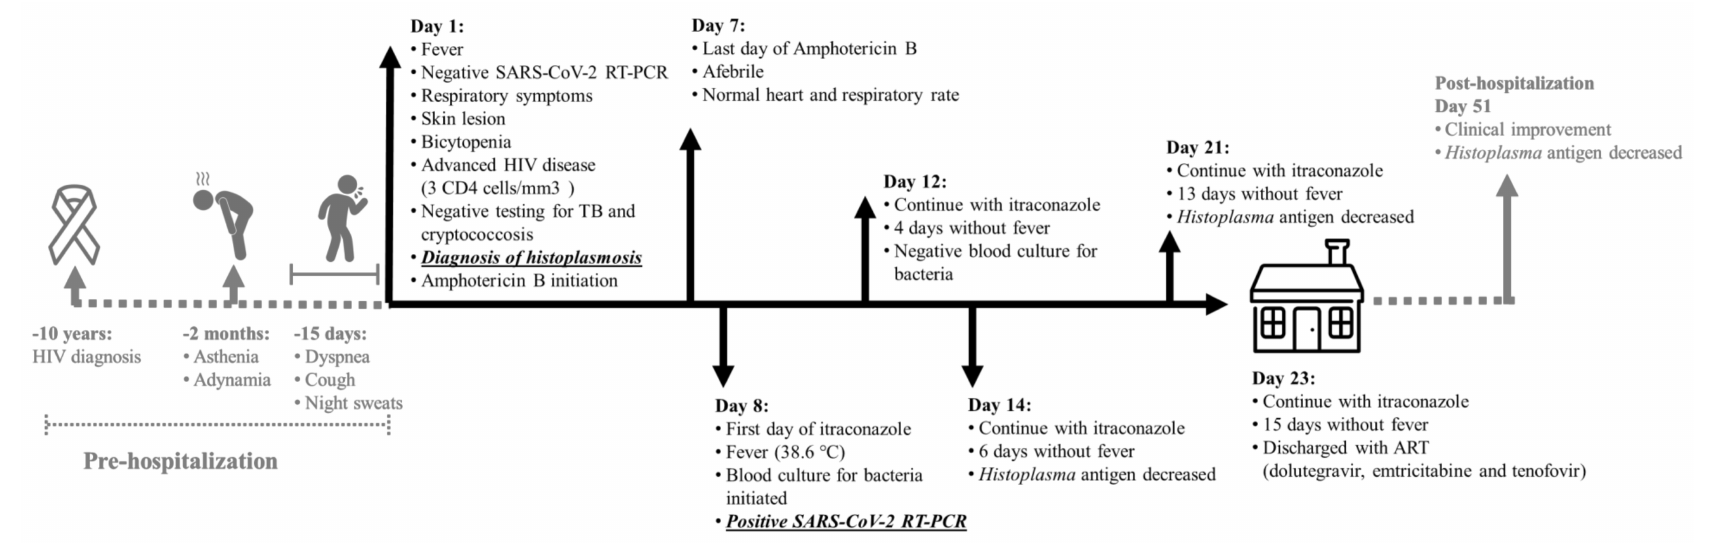
Figure 2. Case timeline: Coronavirus disease 2019 (COVID-19) in a patient with progressive disseminated histoplasmosis from